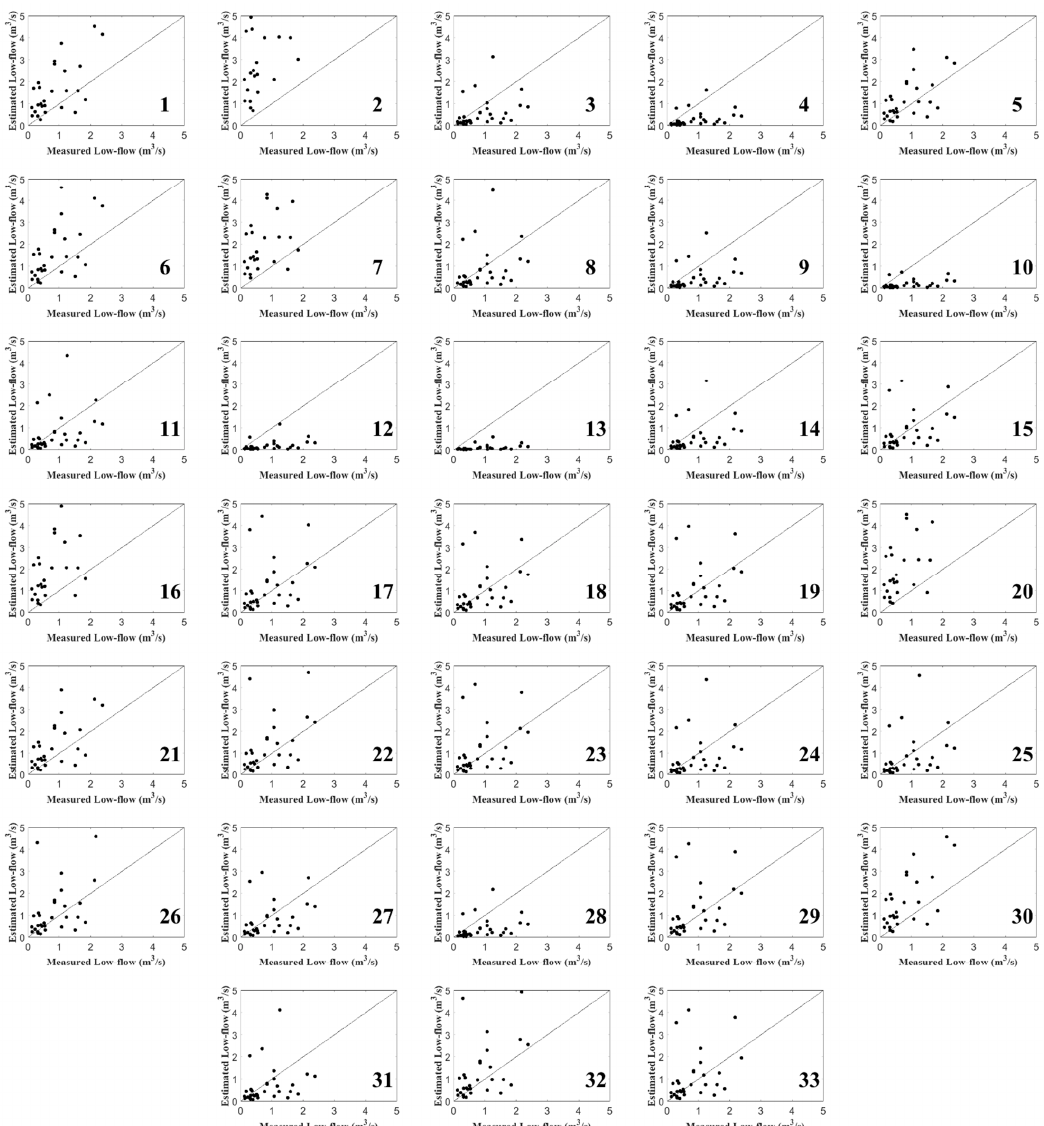
Figure 5. Plot of the estimated low-flow and measured low-flow values for the two-year quantile based on 33 river networks using the drainage-area ratio method.